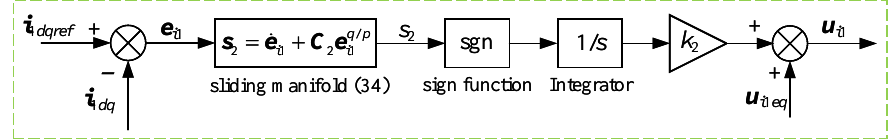
Figure 3. Calculation flowchart of the full-order terminal sliding-mode control